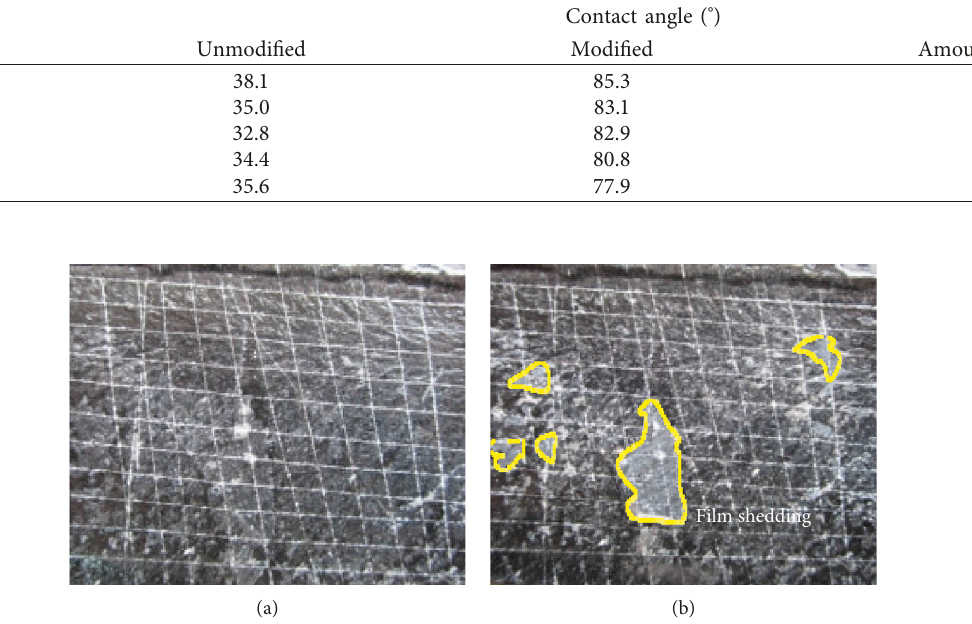
Figure 8: Photos showing the scratches on the membrane layer. (a) Rules of the graphics after scratch. (b) Shedding situation of the membrane